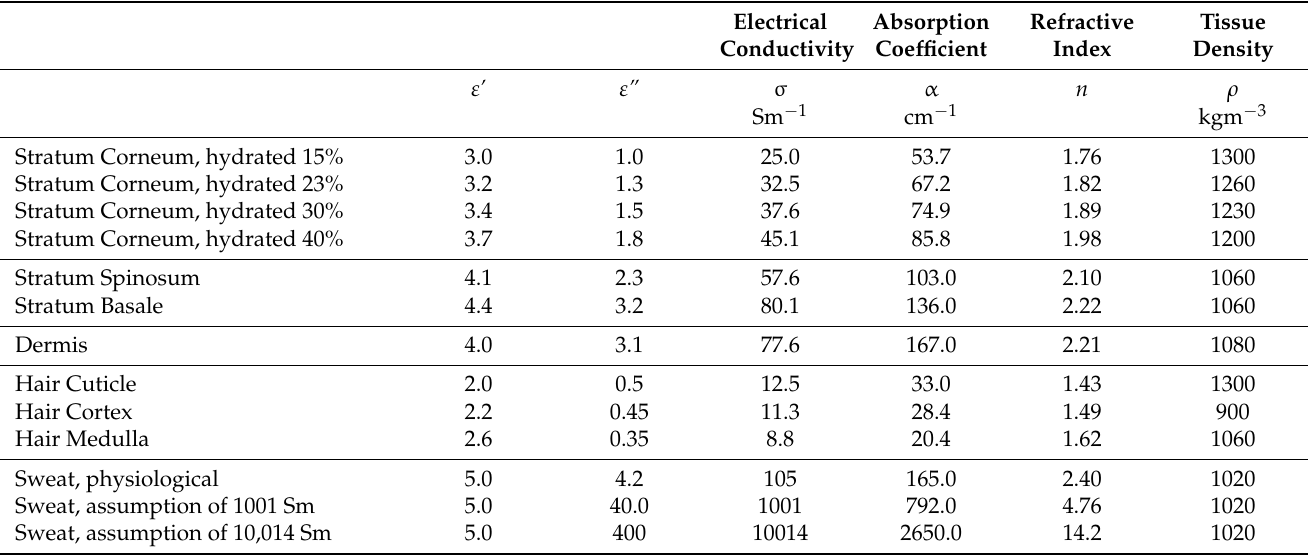
Table 2. Dielectric Properties of Skin Components at 0.45